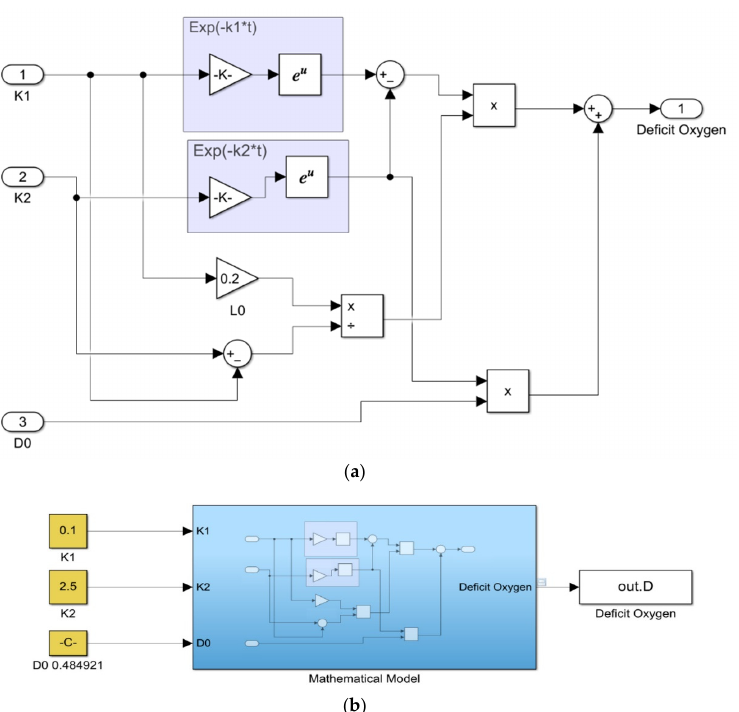
Figure 5. ( a ) Mathematical modeling simulation of oxygen deficit. ( b ) MATLAB Simulink subsys ‐ tem of oxygen